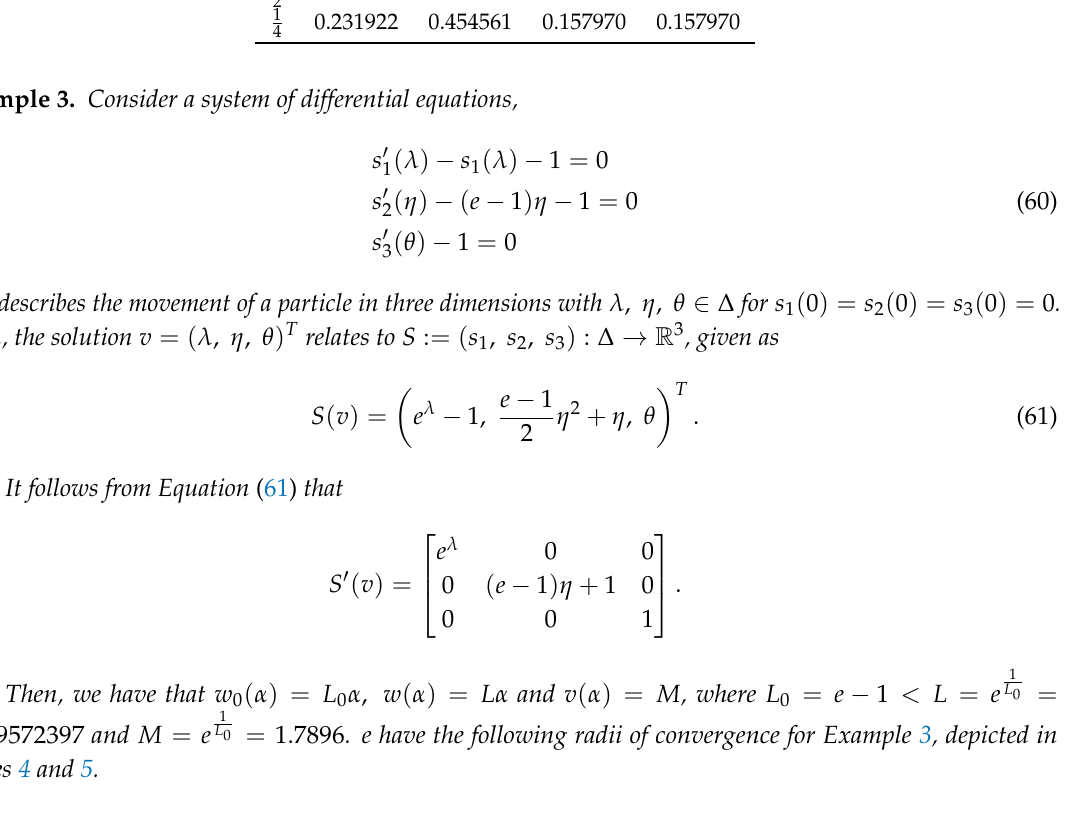
Table 4. Convergence radii for Example 3.